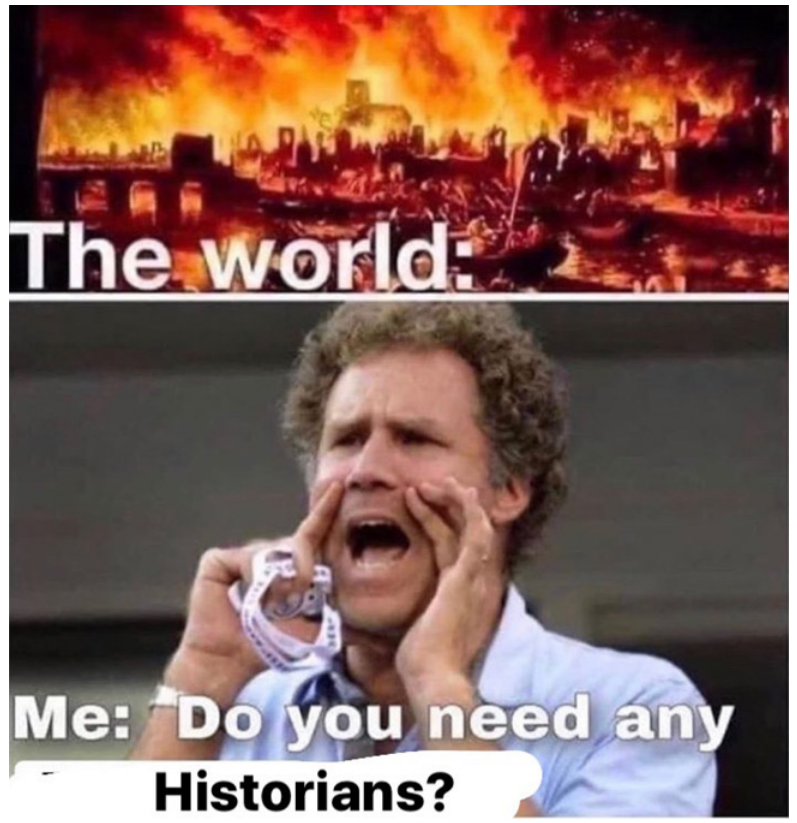
Instagram meme. Sourced 11 September